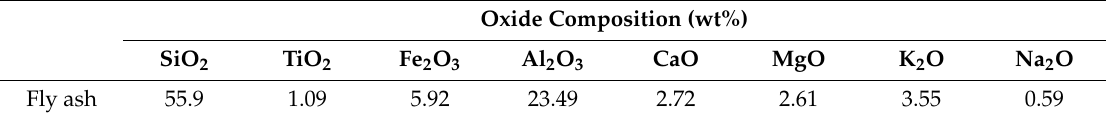
Table 1. Oxide composition of fly ash.